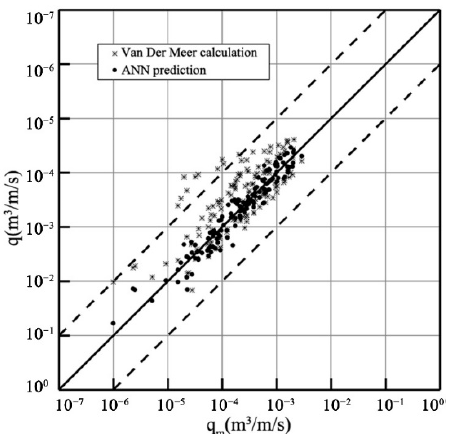
Figure 12. Comparison of the estimated value of the ANN model, the European Van der Meer formula, and the experiment.